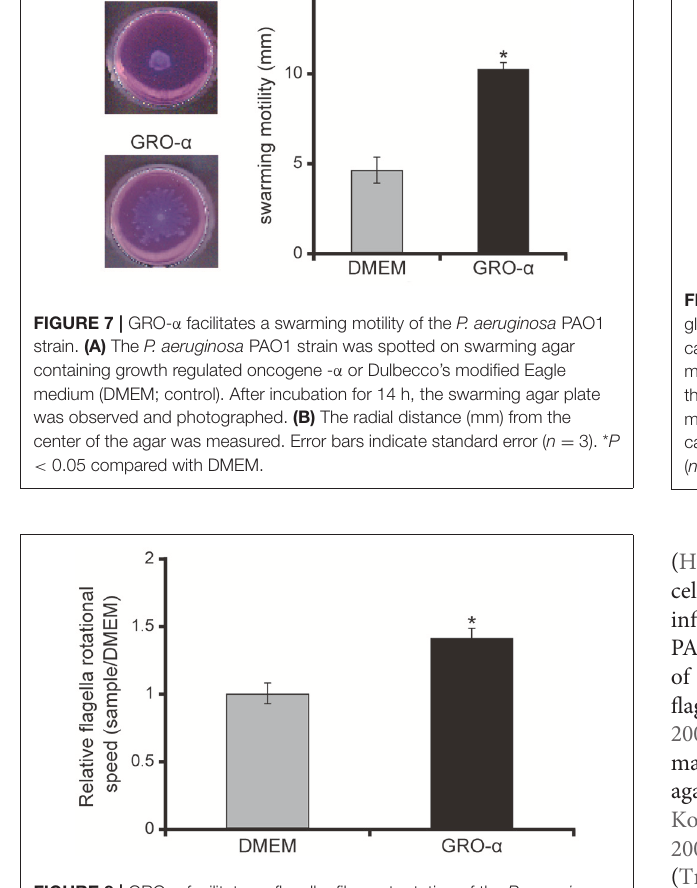
FIGURE 8 | GRO- α facilitates a flagellar filament rotation of the P. aeruginosa PAO1 strain. P. aeruginosa PAO1 strain cells were loaded onto a glass slide precoated with flagellar filament FliC antibodies, and growth regulated oncogene- α or Dulbecco’s modified Eagle medium (DMEM; control) was added. Bacterial cells were visualized and recorded as a movie using EVOS microscope, showing videos of the tethered bacteria. The rotational speed was calculated from the number of rotations in 60s. Error bars indicate standard error ( n = 10). * P < 0.05 compared with DMEM.